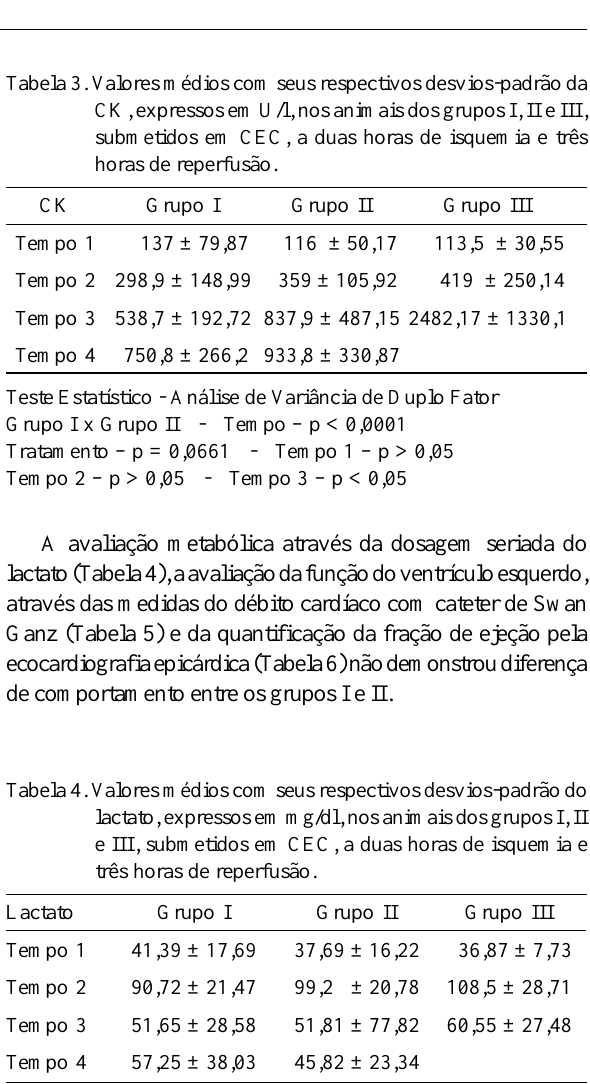
Teste Estatístico - Análise de Variância de Duplo Fator Tabela 5. Valores médios com seus respectivos desvios-padrão do débito cardíaco, expressos em l/min, nos animais dos grupos I e II, submetidos em CEC, a duas horas de isquemia e três horas de reperfusão.